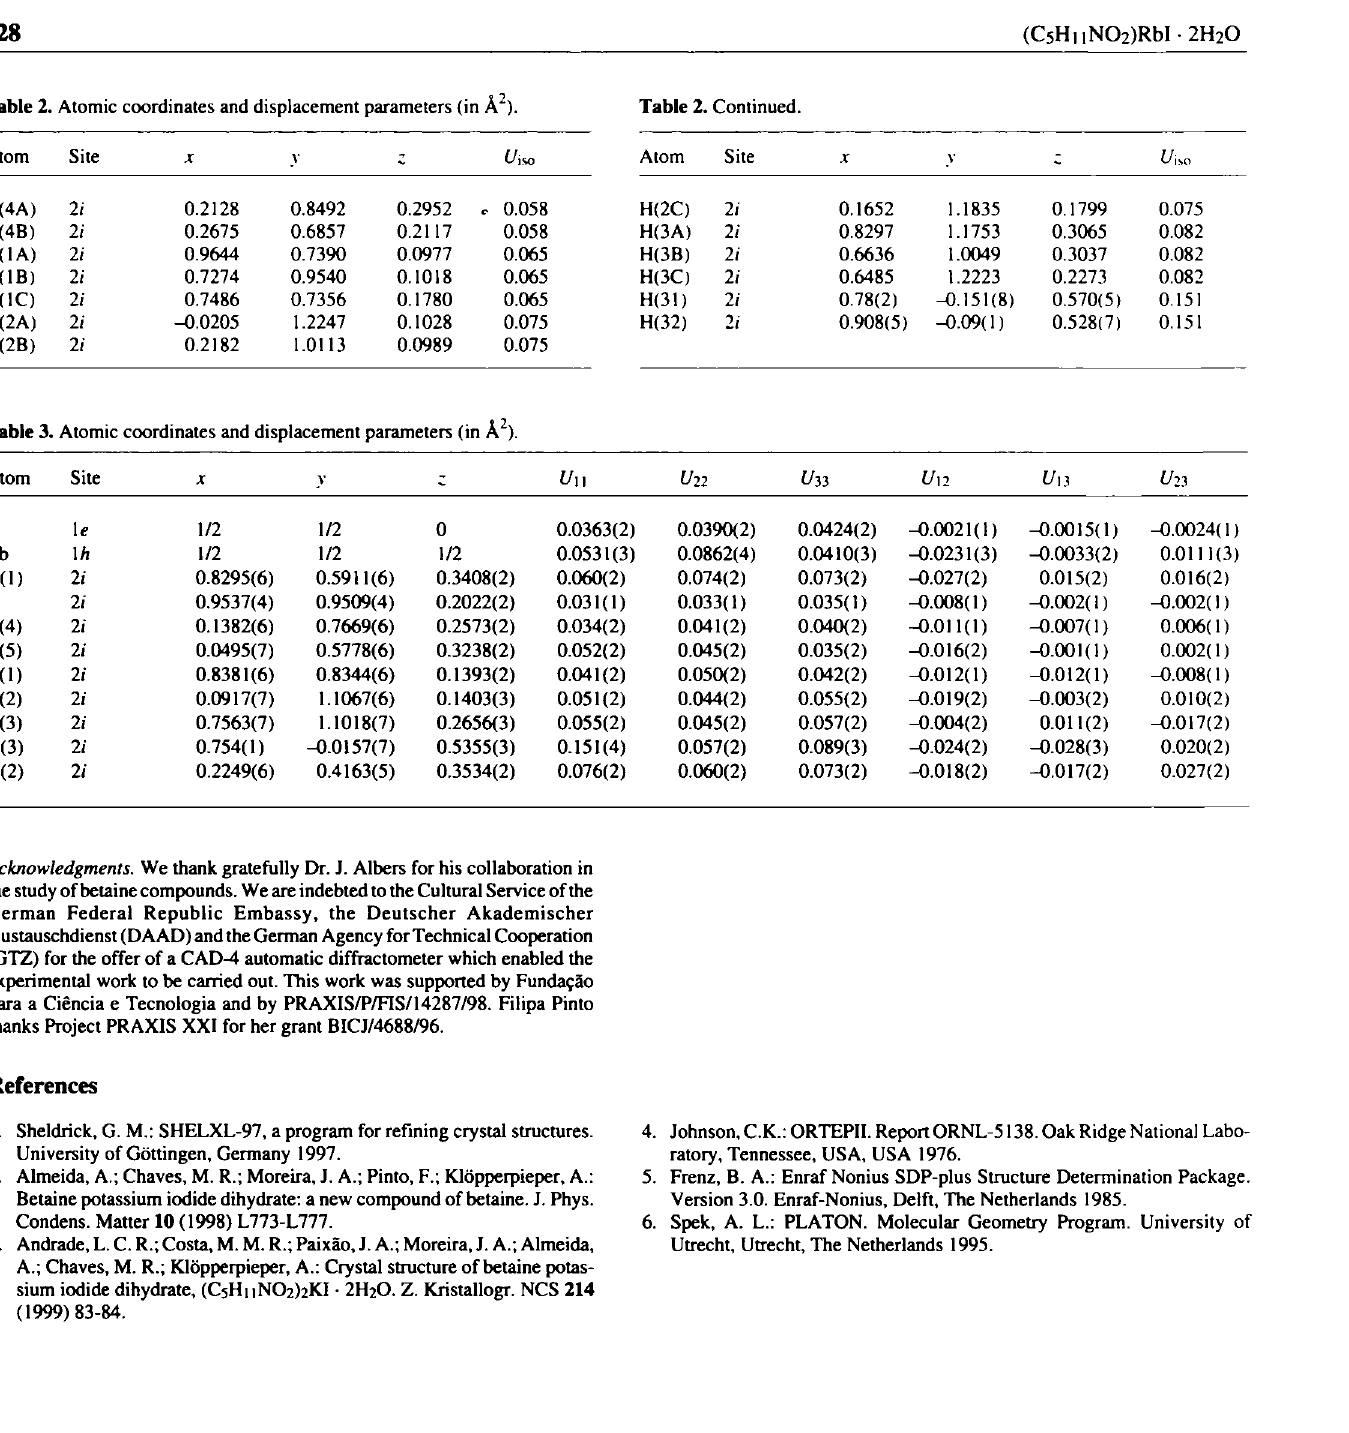
Table 2. Atomic coordinates and displacement parameters (in Ä 2 ). Table 2. Continued.